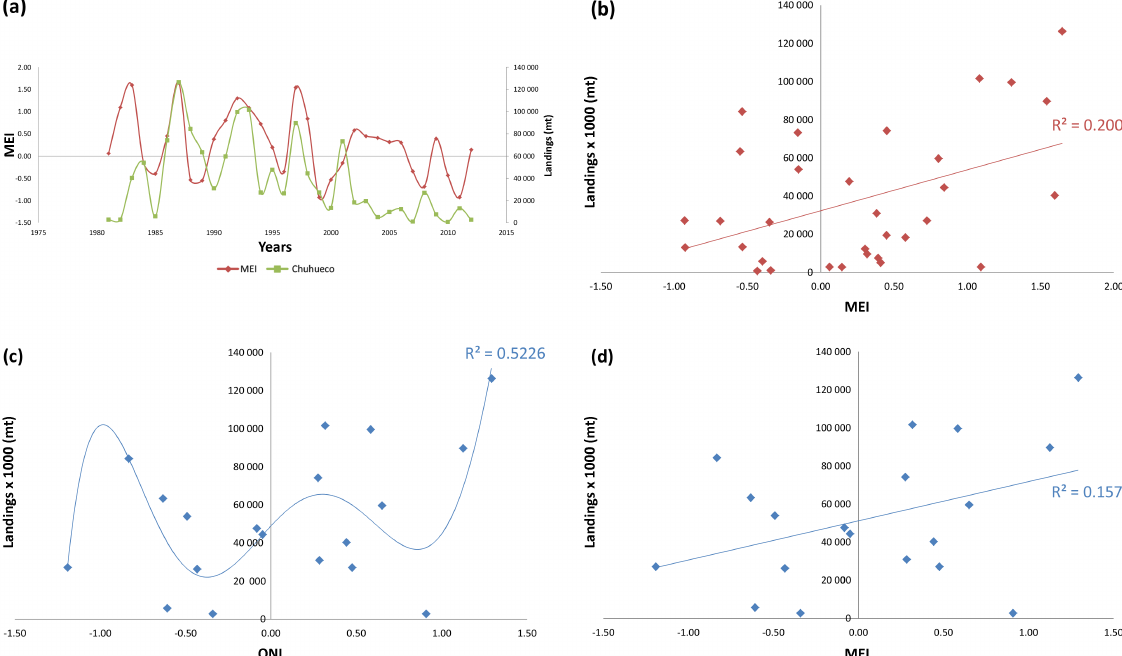
Figure 10. Chuhueco landings (1981–2012) vs. ONI and MEI. (a) Landings vs. MEI, linear correlation landings vs. MEI (b) and ONI (d) , and (c) polynomial ( n =